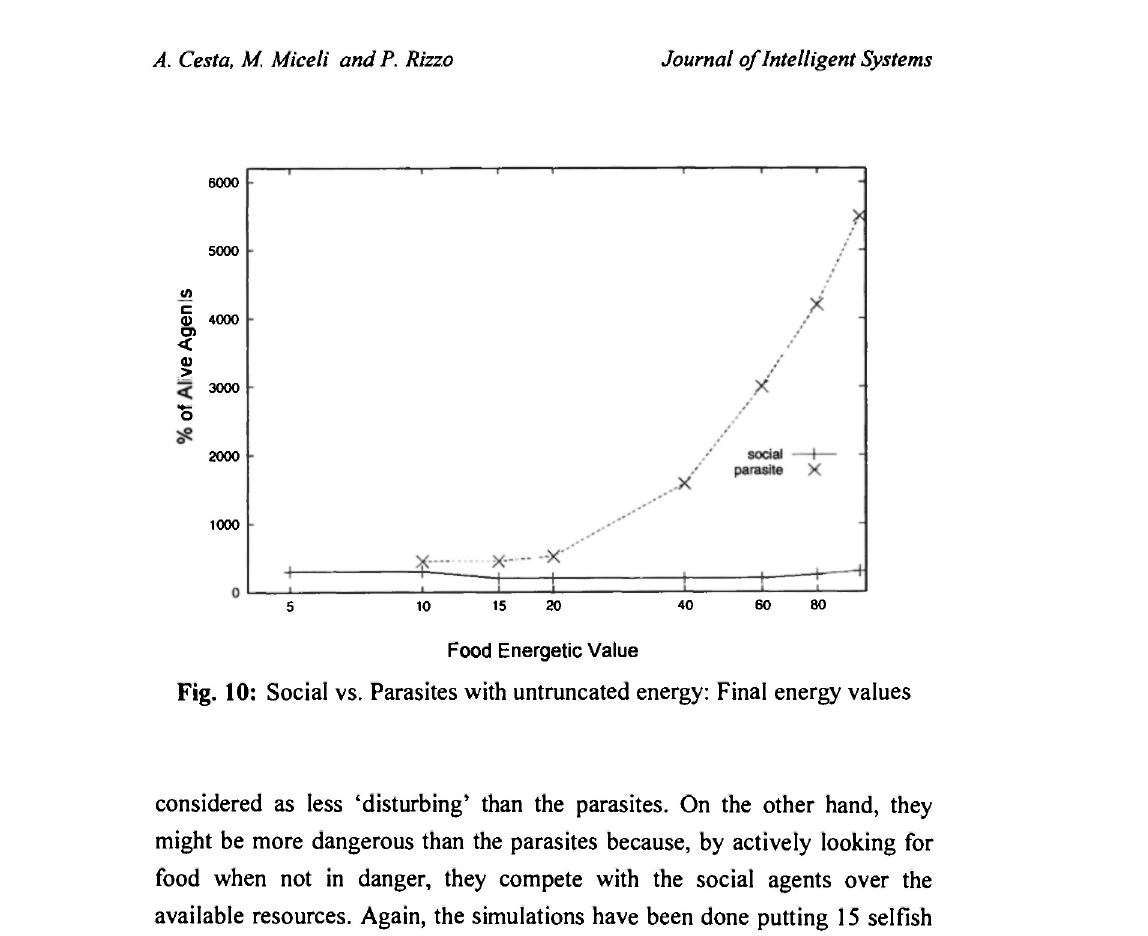
considered as less 'disturbing' than the parasites. On the other hand, they might be more dangerous than the parasites because, by actively looking for food when not in danger, they compete with the social agents over the available resources. Again, the simulations have been done putting 15 selfish and 15 social agents in the same environment. In a first series of simulations, the chosen metric was just survival. The results are shown in Fig. 11. According to the results, both selfish and social agents perform at their best (100% of survived agents of each type) for each energetic value of the food but the two lowest ones (5 and 10), so that their curves are almost identical (for this reason, the curve for the average performance of the two groups taken together has not been plotted). In other words, when the food is quite 'energetic', the performance of the whole system is excellent, and the selfish do not impair the performance of the social agents. In those cases, however, in which the energetic value of the food is very low, statistically significant differences emerge: the selfish definitely outperform the social agents, whereas the latter are clearly 'disturbed' by the selfish (as also results from comparing the percentages of the survived social agents here with those